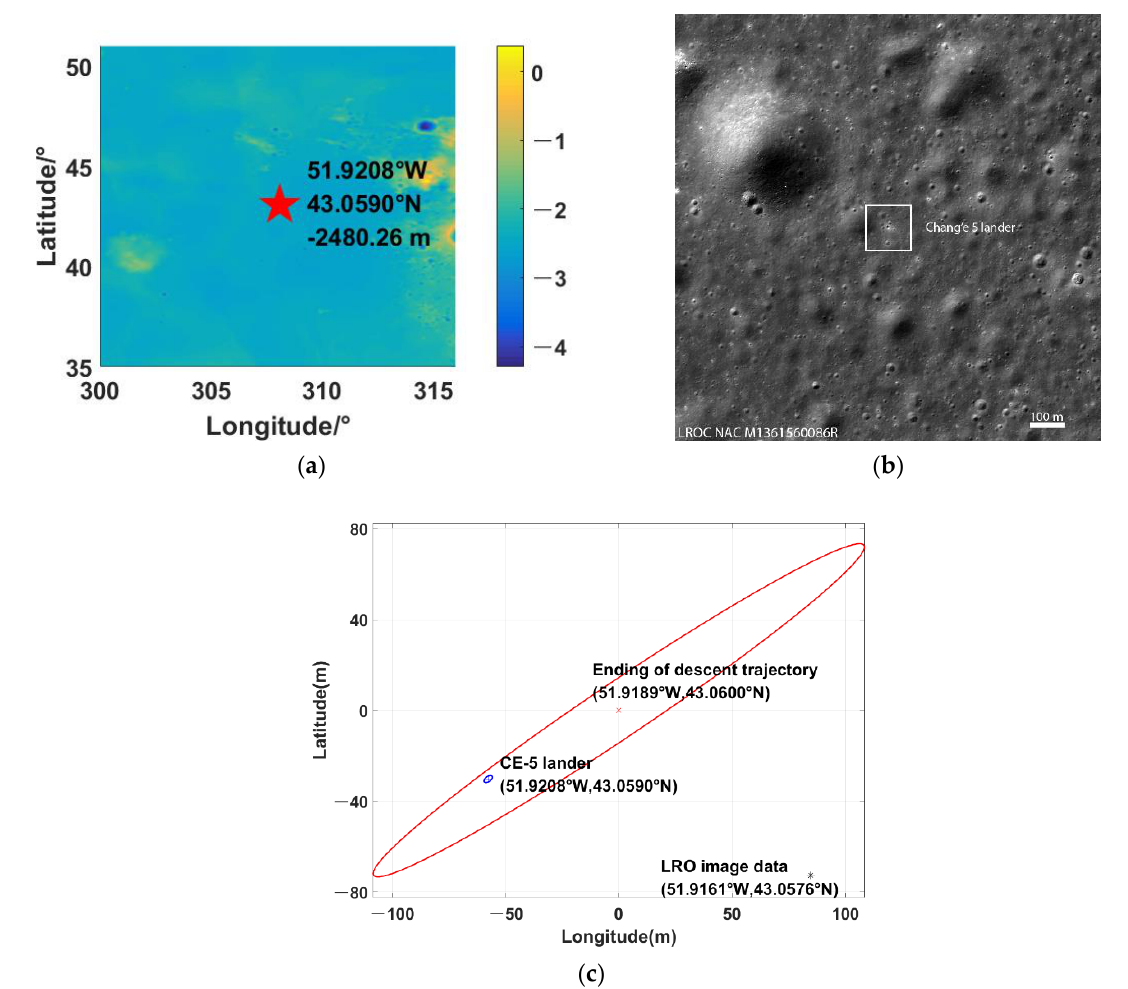
Figure 5. Landing positioning results: ( a ) our landing positioning result; ( b ) CE-5 lander taken by LRO; ( c ) landing error ellipse and error ellipse of ending point in descent